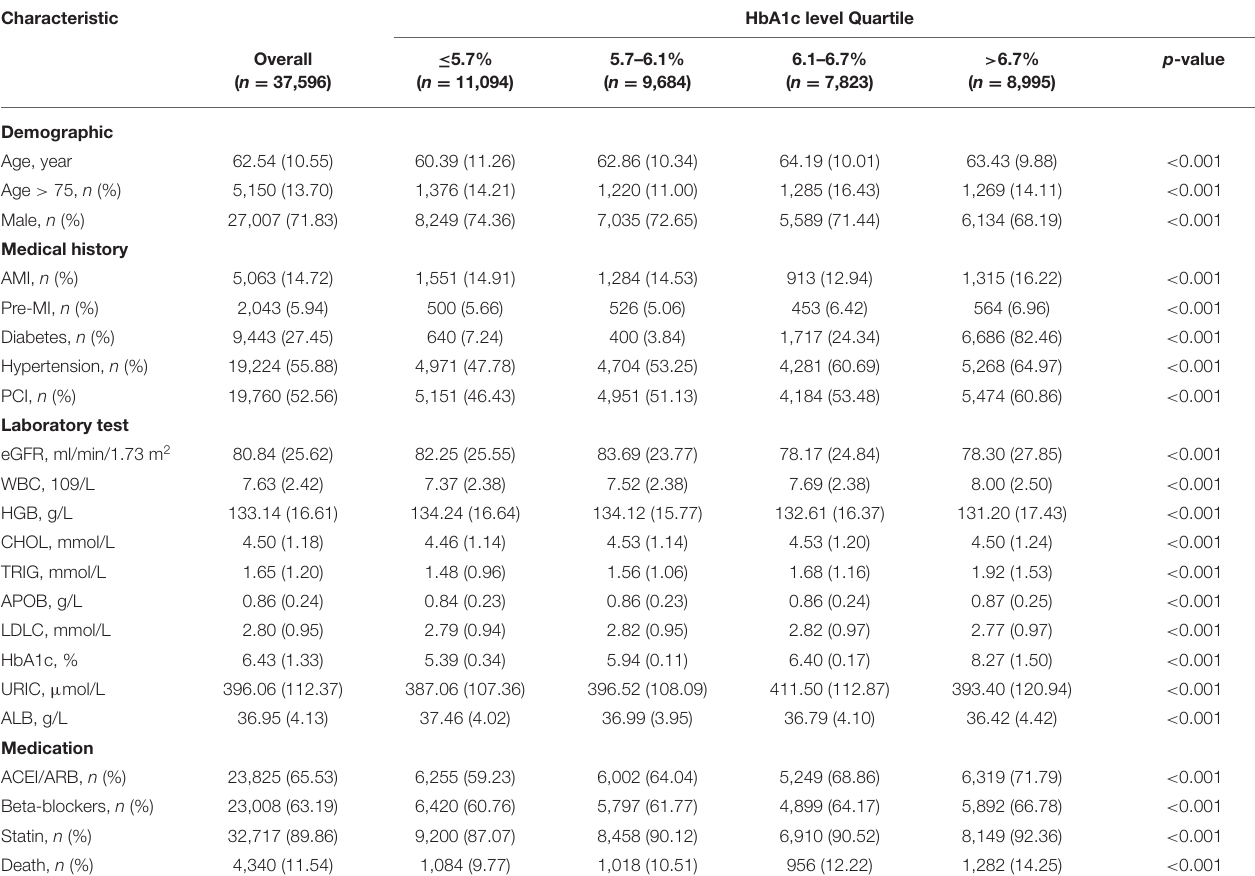
TABLE 1 | Baseline characteristics of the patients.